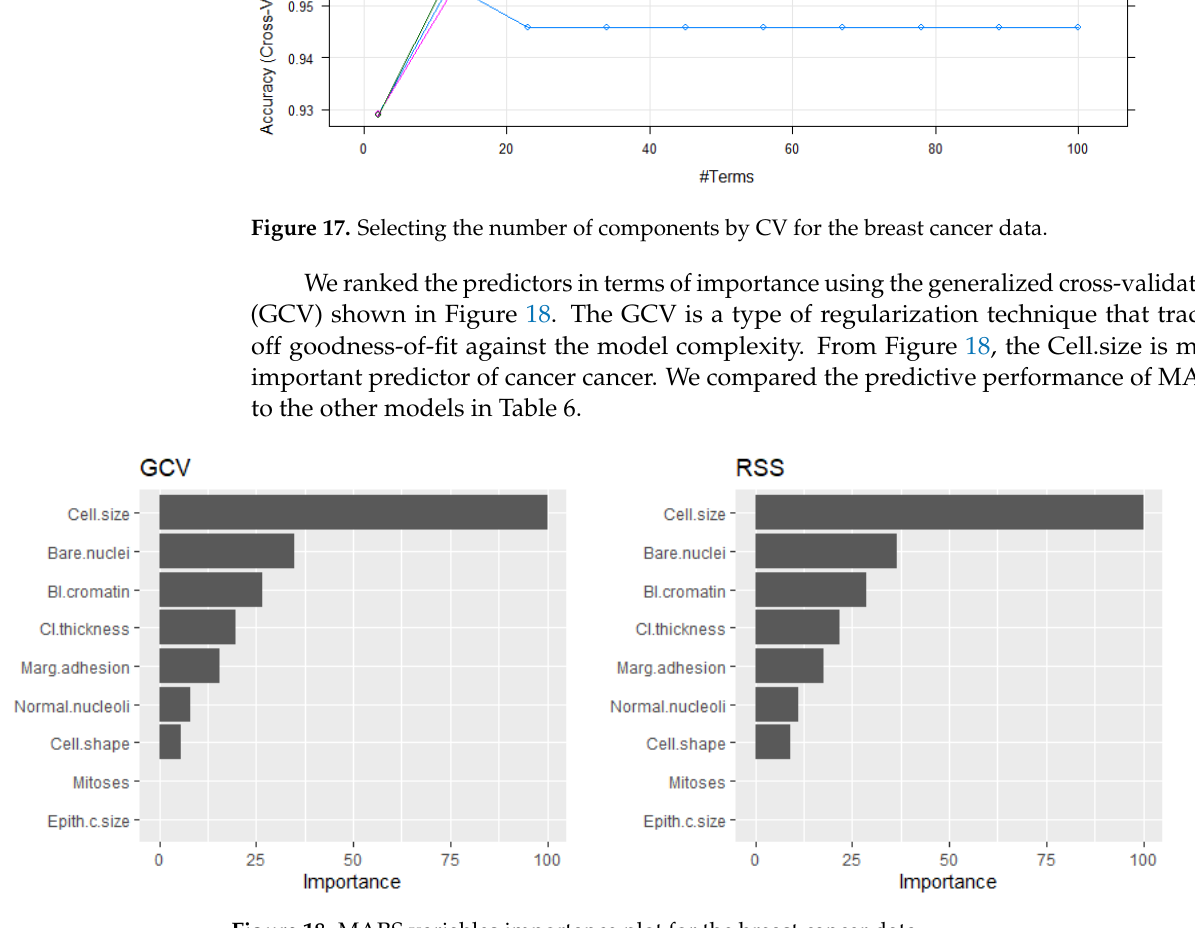
Figure 18. MARS variables importance plot for the breast cancer data.